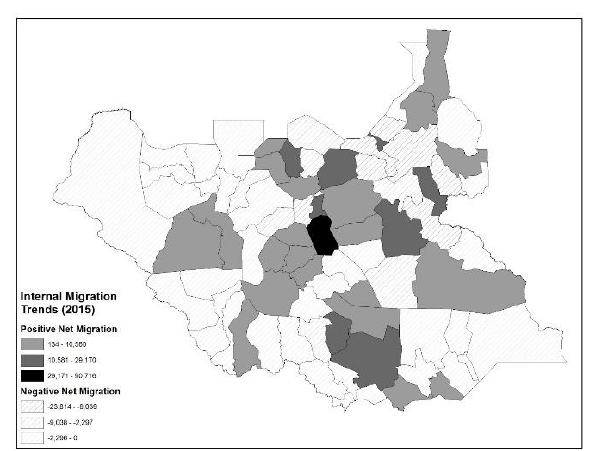
Figure 8. Internal Migration Estimates for 2015 The results of internal migration were combined with the international out-migration estimates from the refugee model, which are shown in Figure 9. These values summarize the key regions of disruption, caused by conflict, based on modeling with existing data on IDPs and refugees. Unlike other forecasts, which produce spatially uniform increases in population; accounting for displacement population reveals that 15 percent of counties ( n = 12) increased in population over 20 percent, and 30 percent of counties ( n = 24) experienced zero or declining population growth, due to internal displacement and refugee out- migration.